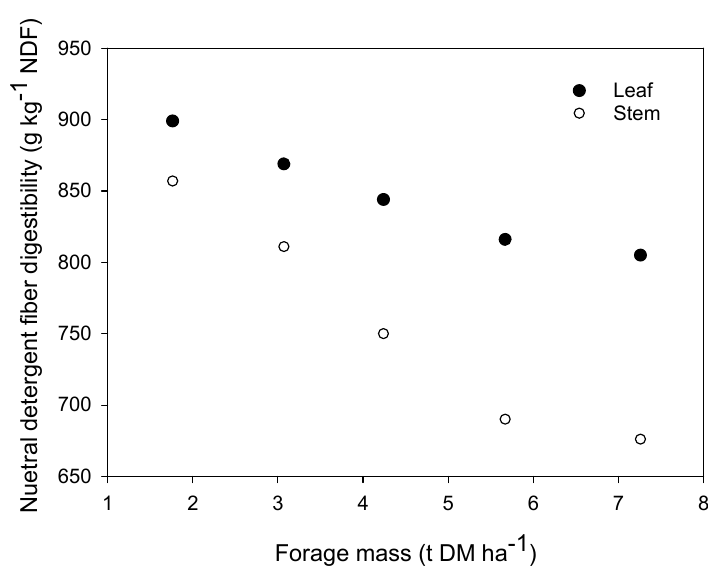
Figure 2. Changes in neutral detergent fiber digestibility of leaves and stems of timothy during spring growth under non-limiting N conditions. Drawn from data obtained at Fredericton (45.55° N; 66.36° W; Canada) and presented in Bélanger and McQueen [26].